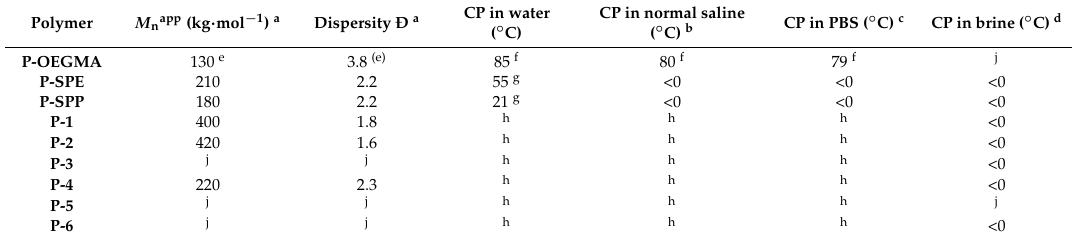
Table 1. Molar masses of the polymers prepared, and their solubility (3 wt %) in various aqueous